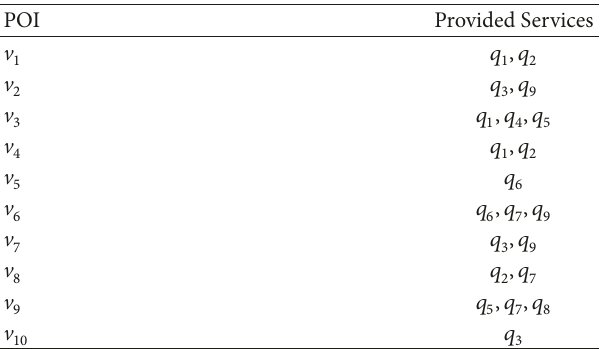
Table 1: POI information. POI Provided